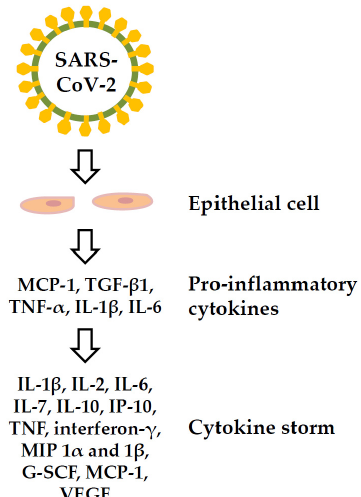
Figure 5. Cytokine storm of the COVID-19 disease. G-SCF: plasma granulocyte colony-stimulating factor, IL: interleukin; IP: interferon-inducible protein; MCP-1: monocyte chemokine-1, MIP: macrophage inflammatory protein, TGF- β 1: tumor growth factor- β 1, TNF: tumor necrosis factor, VEGF: vascular endothelial growth